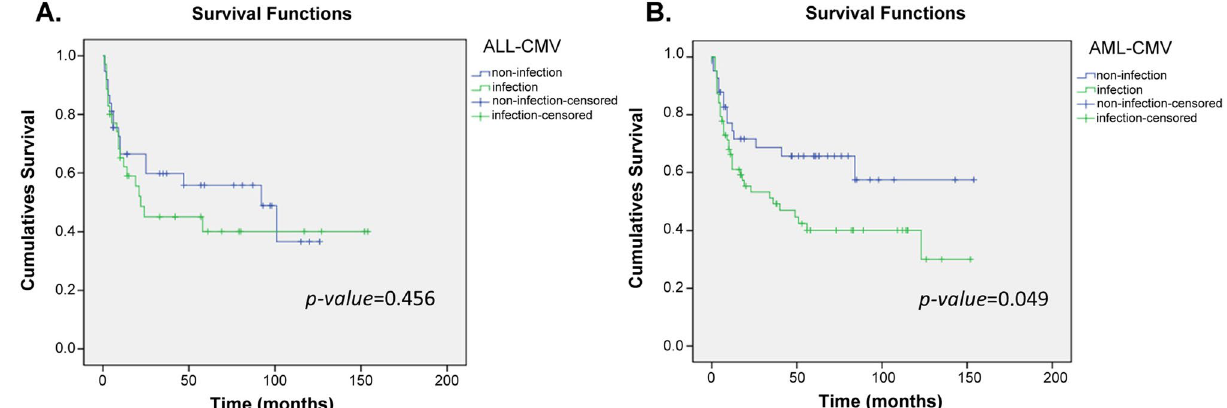
Figure 1. Kaplan–Meier analysis of overall survival curves based on the CMV infection in ALL and AML patients. ( A ) The survivorship curve of CMV in ALL patients. ( B ) The survivorship curve of CMV in AML patients. censoring: the time point of patient death or losing contact; x-axis: the time from receiving transplantation to death. y-axis: the ratio of surviving patients.